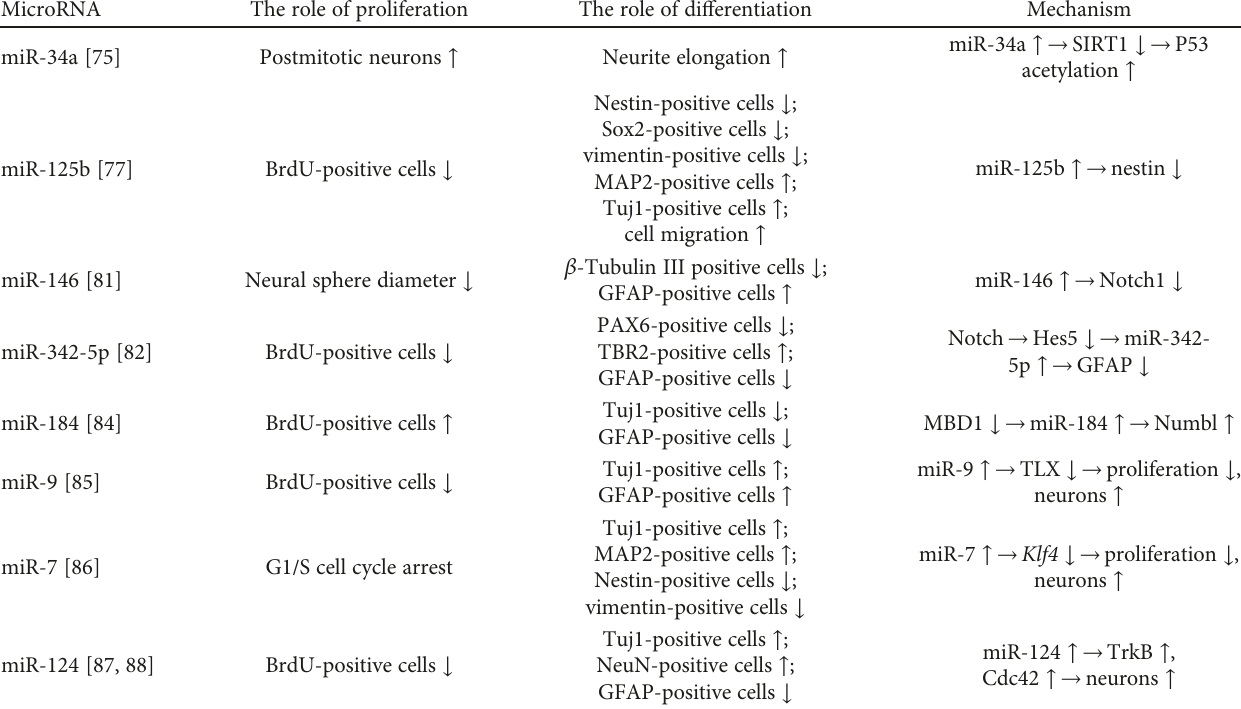
Table 2: E ff ects of microRNAs on the proliferation and di ff erentiation of